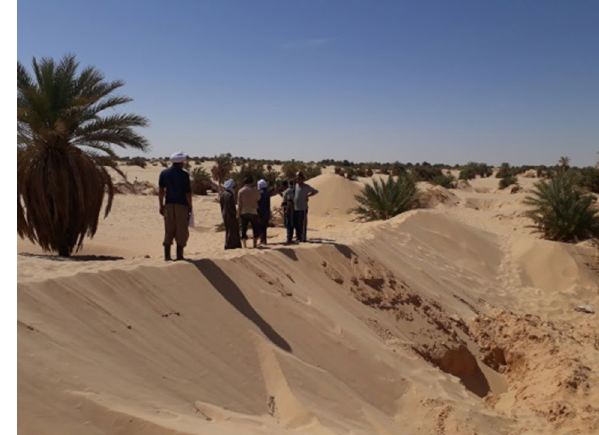
Fig. 14 A view of the silting of part of the palm grove of